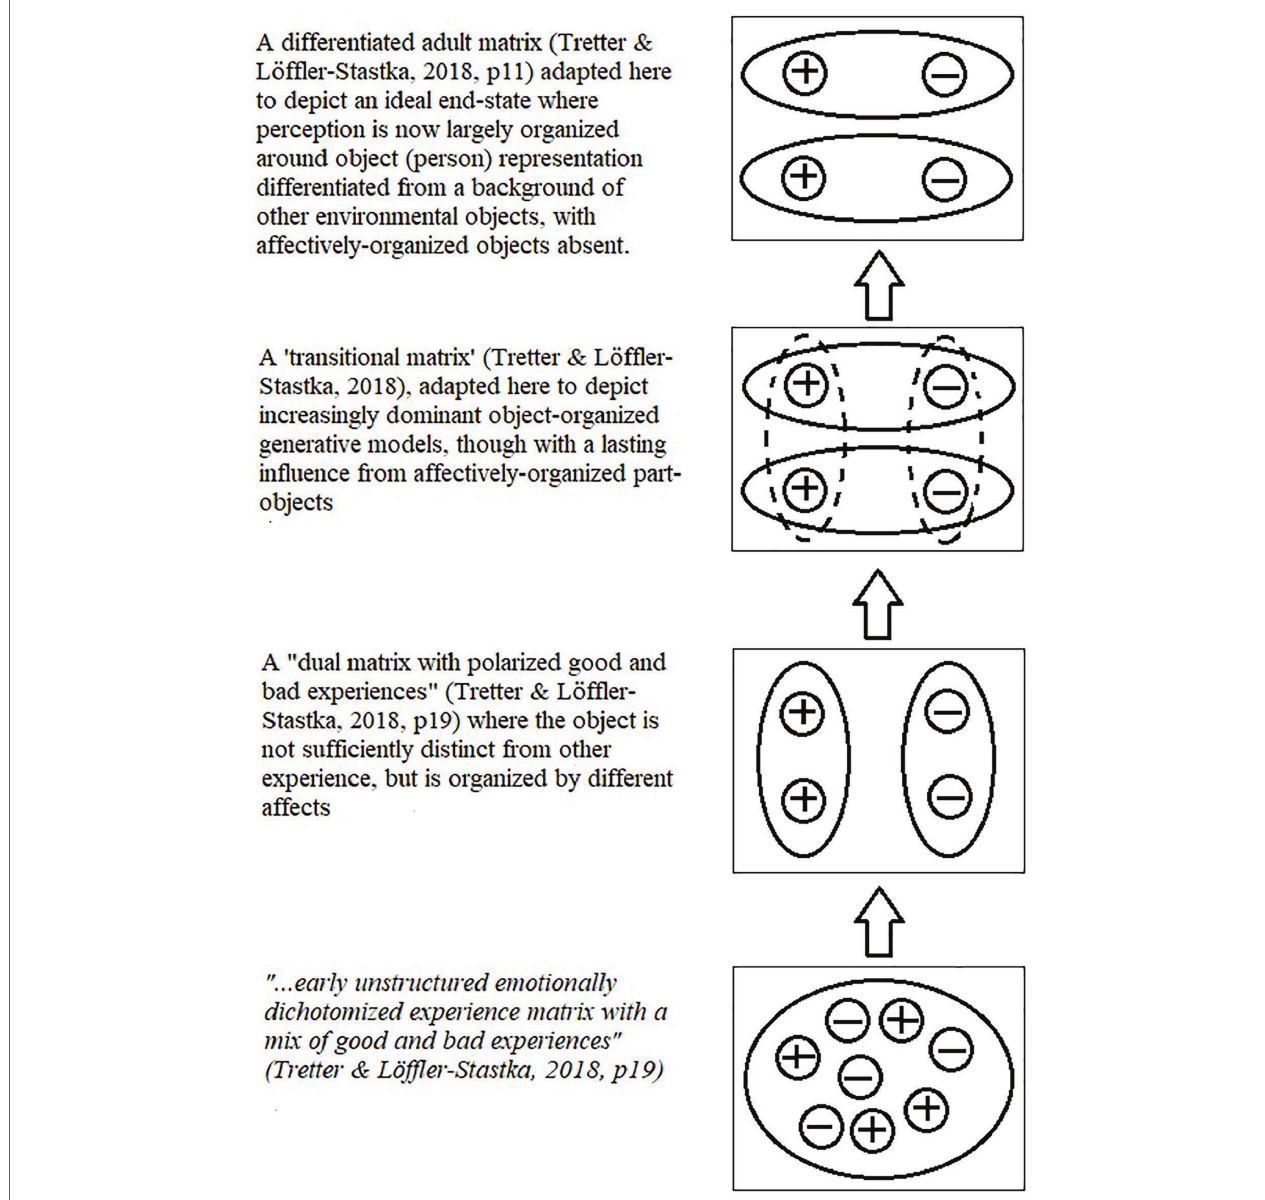
FIGURE 1 | The emergence of person object representation differentiated from other representations, from a lower level of affectively organized part objects (adapted from Tretter and Lo¨ffler-Stastka, 2018, p. 11, with permission from the copyright